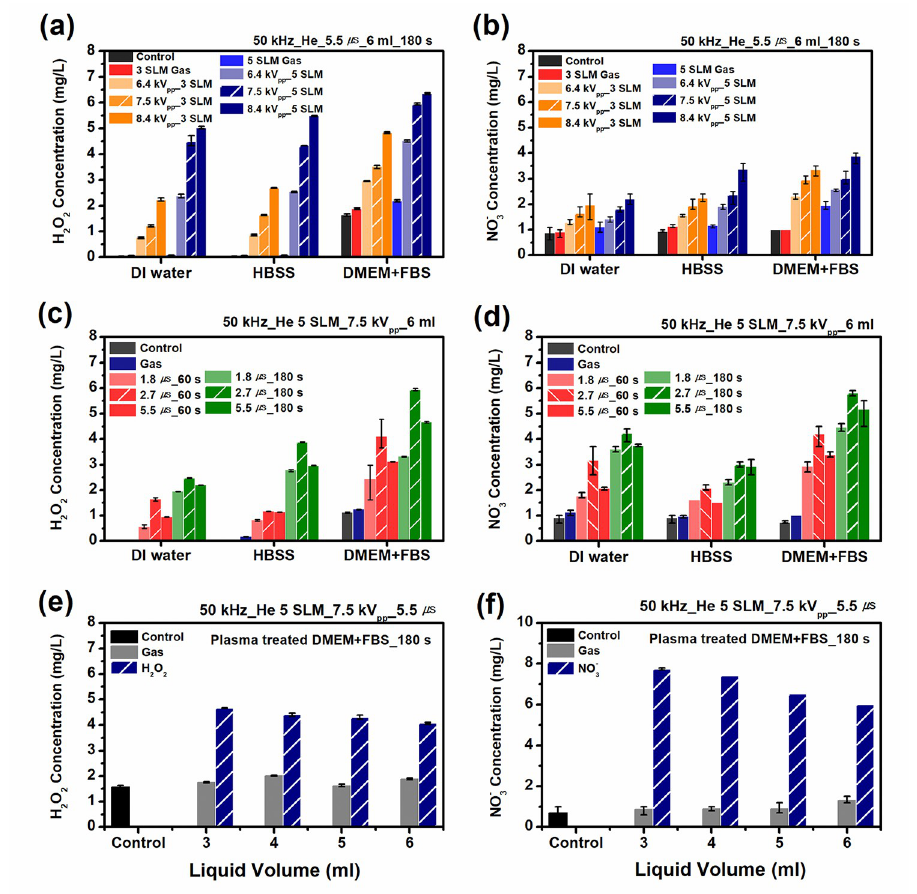
Fig 6. Concentrations of H 2 O 2 and NO 3- produced in the plasma-treated media (DW, HBSS, and DMEM) at different conditions: (a) and (b) present the measured concentration of H 2 O 2 and NO 3- as functions of the applied voltage and the gas flow rate, respectively. (c) and (d) present the measured concentration of H 2 O 2 and NO 3- as a function of the treatment time at three different pulse widths (1.8, 2.7, and 5.5 μ s), respectively. (e) and (f) present the dependence of [H 2 O 2 ] and [NO 3- ] on the volume of media (DMEM + 10% FBS), respectively. In (e) and (f), [H 2 O 2 ] and [NO 3- ] were measured as a function of media volume in the range from 3 ml to 6 ml. The grey bar represents the gas-only treated